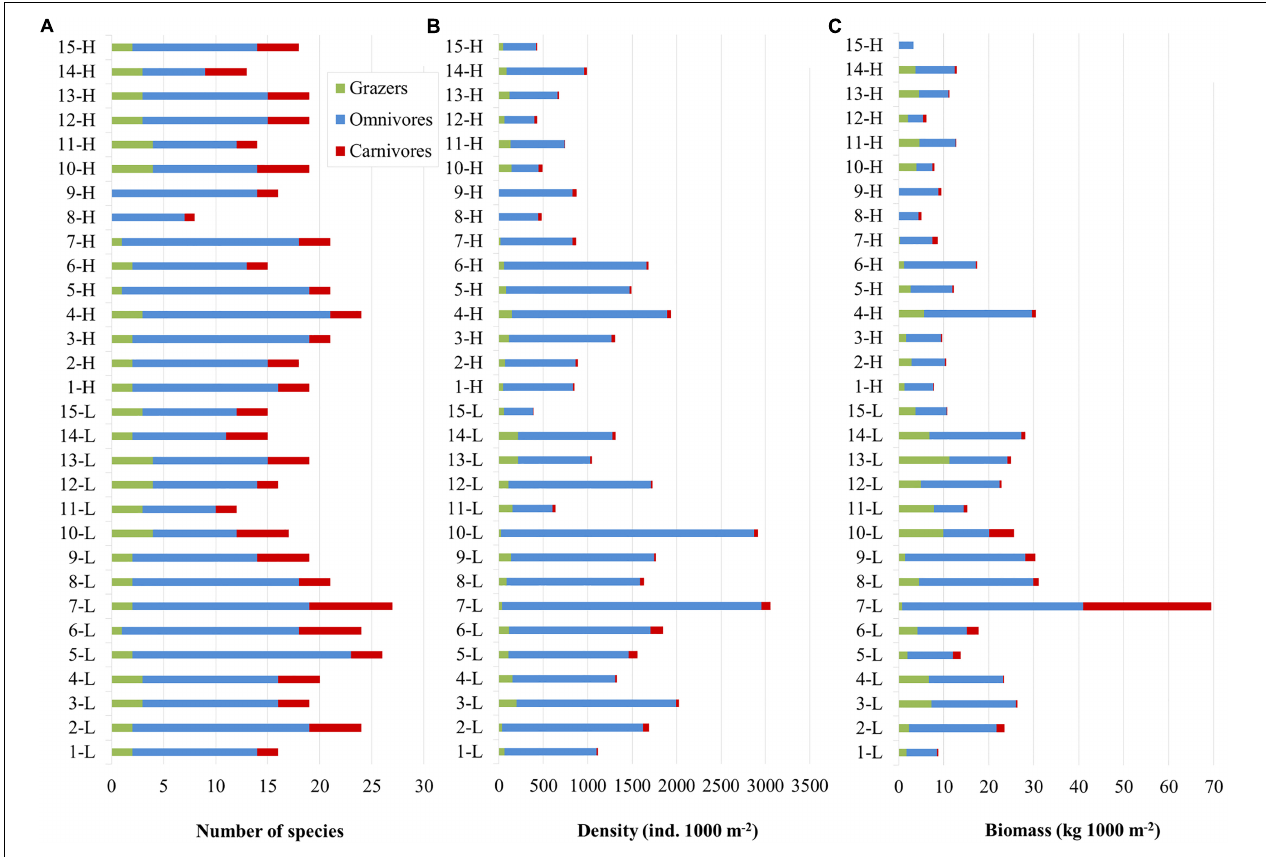
FIGURE 2 | Bar charts displaying fish community parameters per site (5 and 15 m zones pooled); (A) Number of fish species. (B) Total fish abundance. (C) Total fish biomass. L: low fishing pressure site, H: high fishing pressure site, Green: grazers, Blue: omnivores, Red: carnivores. Station ID numbers 1–9 correspond to N Aegean sites, whereas 10–15 correspond to S Aegean